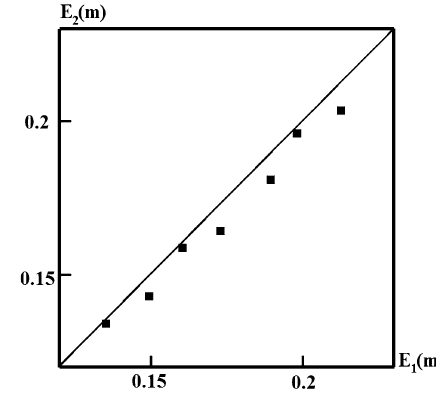
Fig. 8 Comparison of specific energy at upstream and downstream of side weir for different passing flows through circular channel